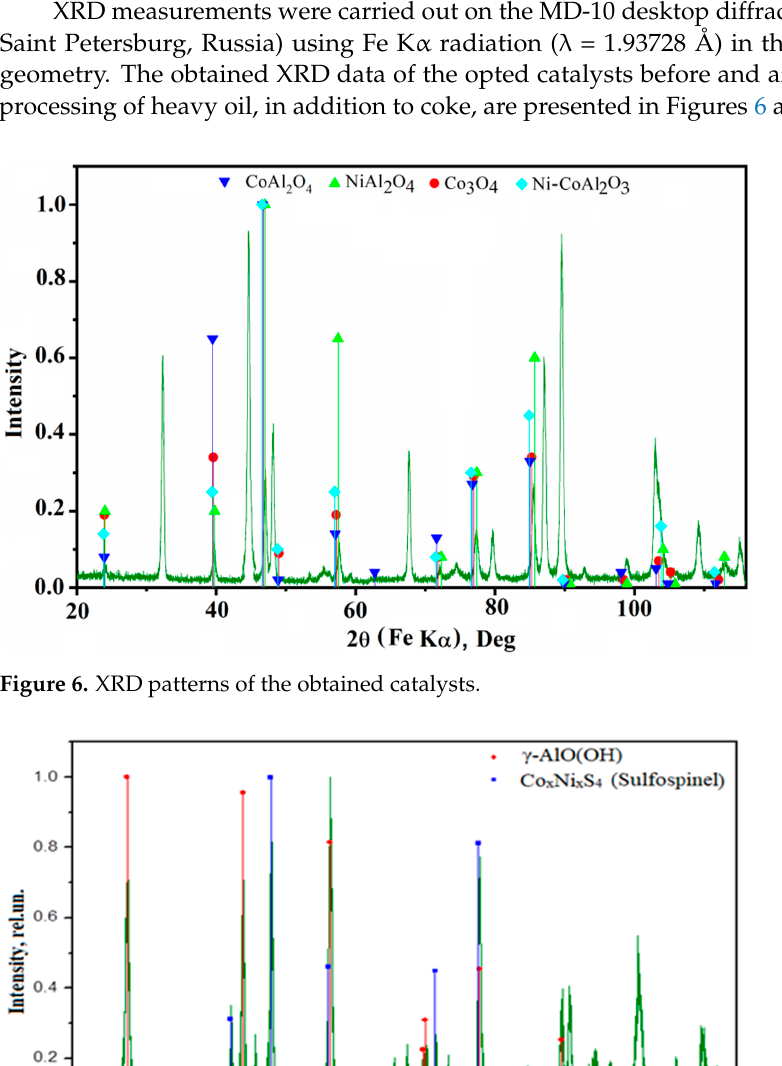
Figure 8. Morphological structure of Co/Al 2 O 4 ( A ) and Ni/Al 2 O 4 ( B ) catalysts obtained from SEM. Figure 9. Morphological structure of Ni-CoAl 2 O 3 obtained from SEM.